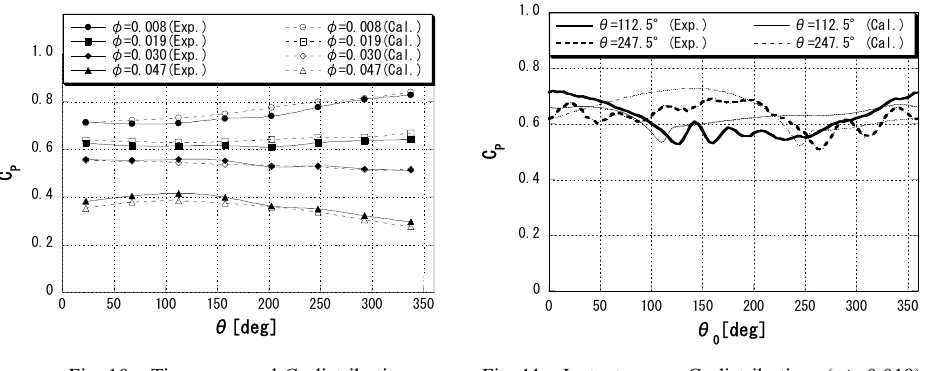
Fig. 10 Time averaged C P distributions Fig. 11 Instantaneous C P distributions ( φ